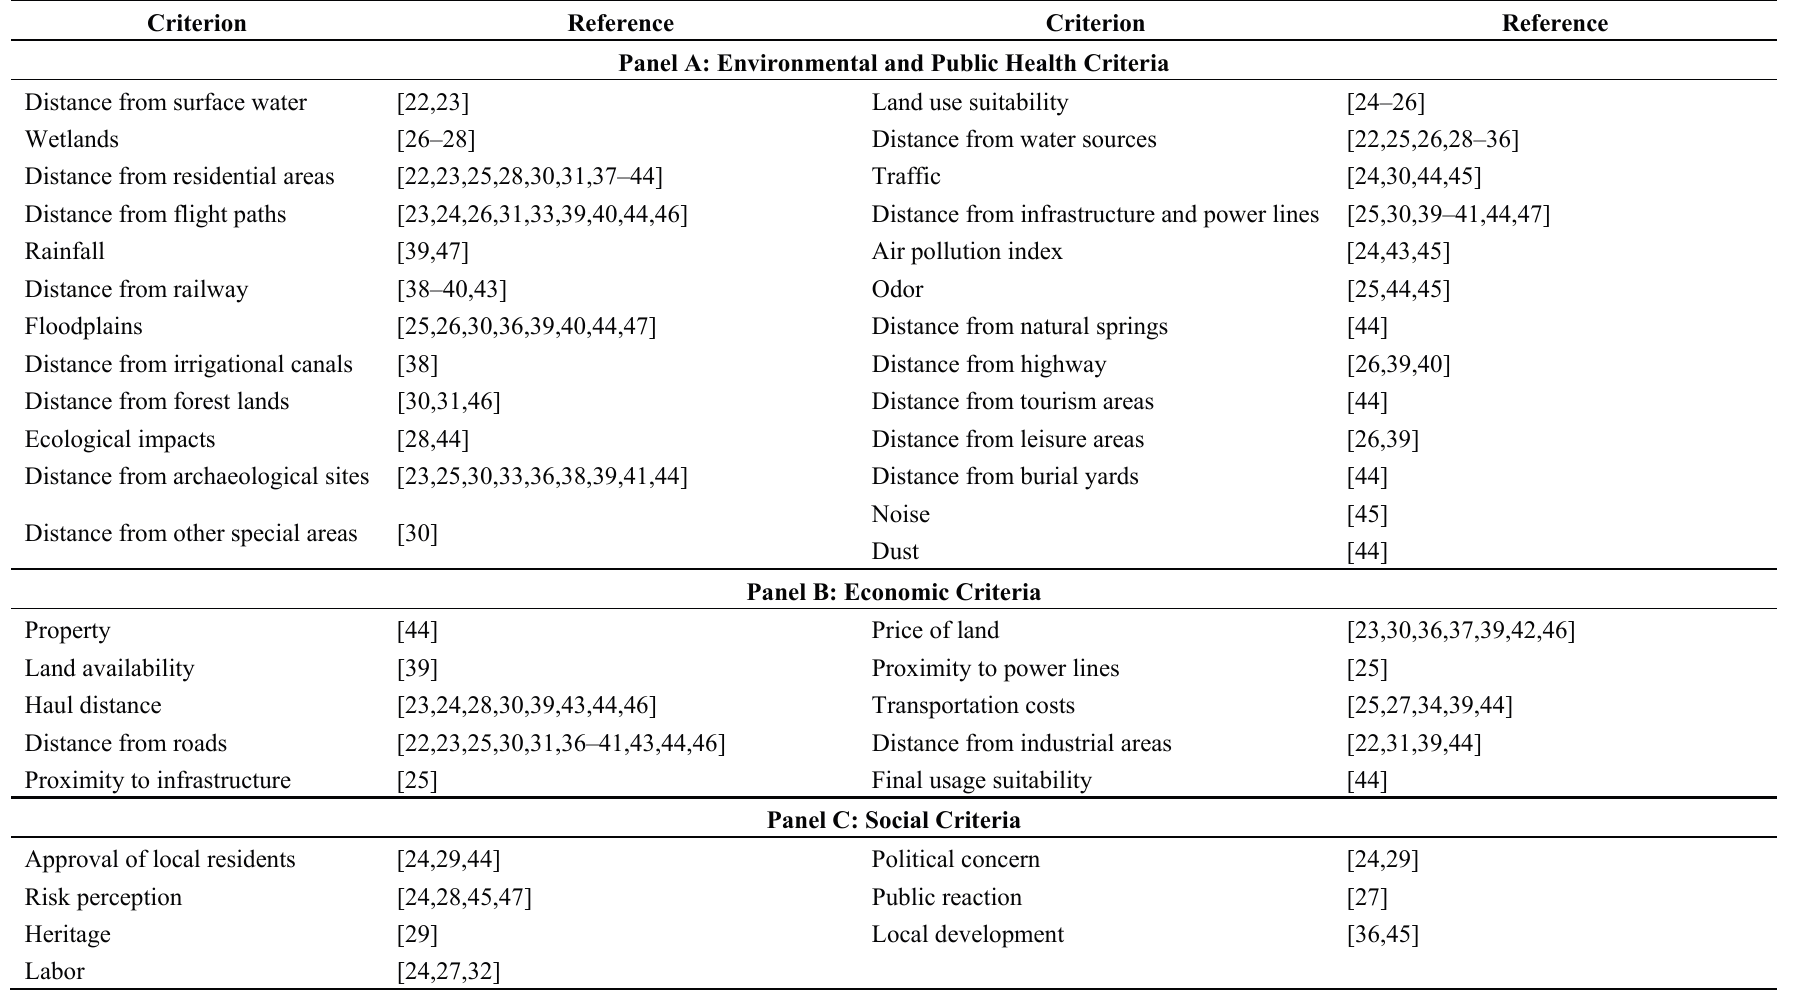
Table 3. Criteria of evaluation system with related